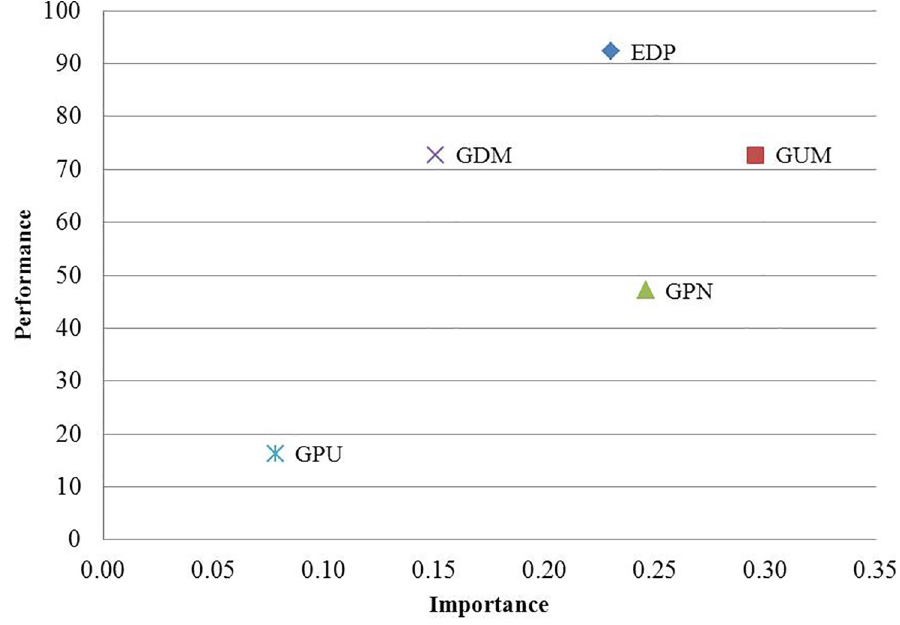
Fig 8. Importance-performance analysis of green supply chain initiatives.